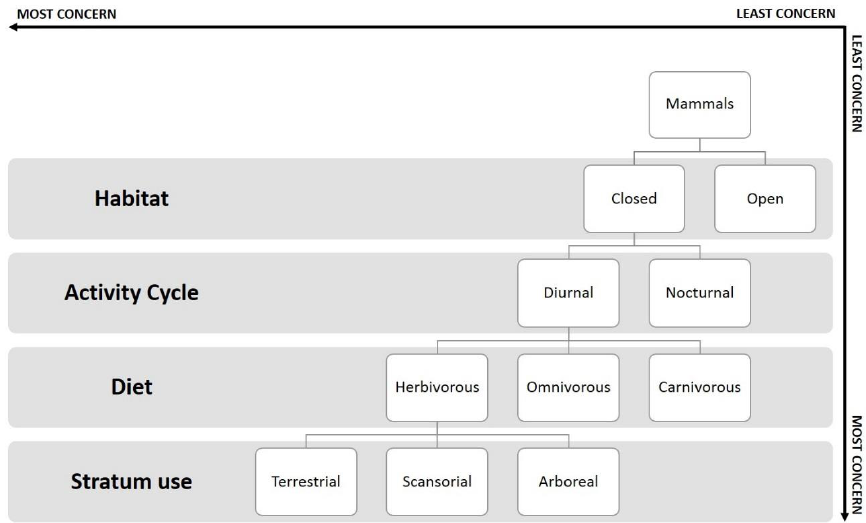
Figure 1. First iteration of a predictive model for zoo mammals’ response to visitors’ presence. Species located on the top-right of the diagram could be considered of least concern regarding the zoo visitors’ effect. Species located on the bottom-left could be considered of most concern regarding the zoo visitors’ effect.